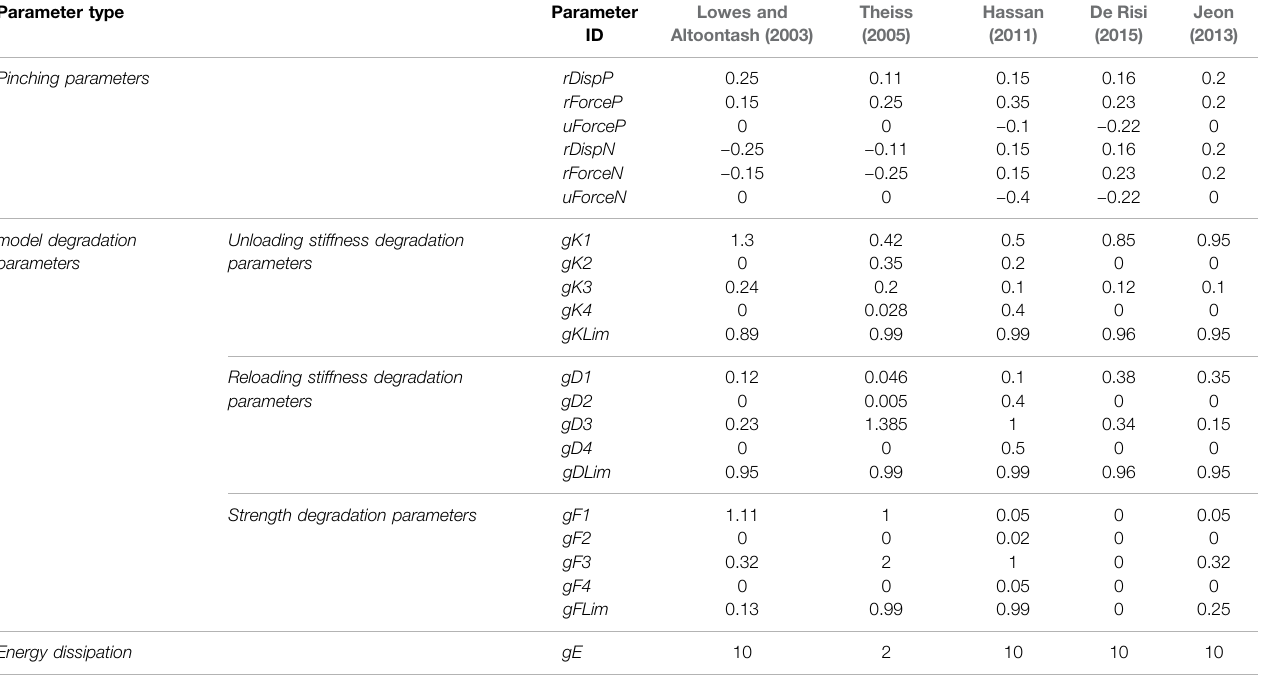
TABLE 10 | Values of the “ Pinching4 ” material parameters selected from the literature. Parameter